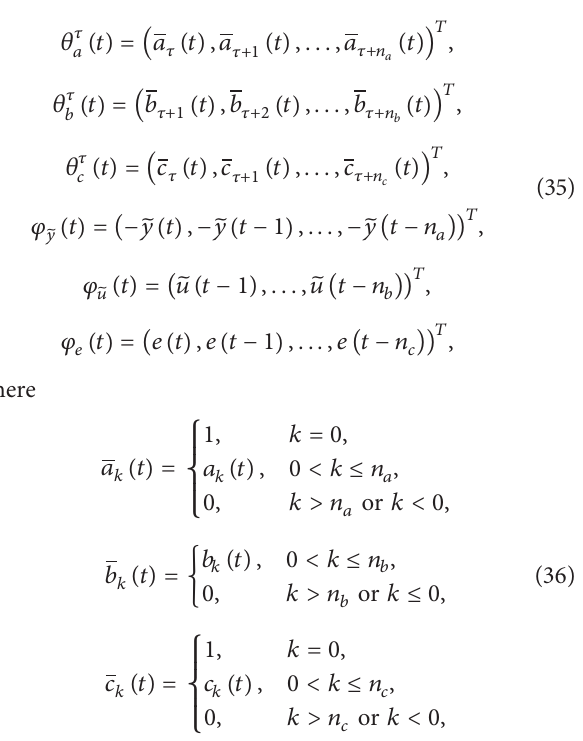
Table 1: Estimation results of System